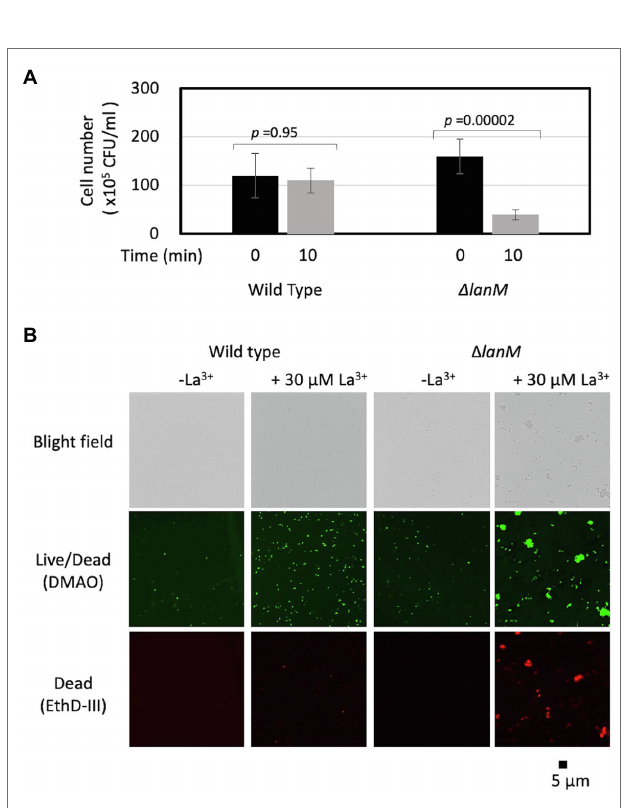
FIGURE 6 | Cell aggregation of Δ lanM upon exposure to La 3+ . (A) Determination of CFUs of the wild type and Δ lanM before and after exposure to 30 μ M La 3+ . Data are presented as the mean value ± standard deviation (SD; n = 3) and analyzed with Student’s t -test. (B) Fluorescent microscopic analysis of the Live/Dead-stained wild type and Δ lanM exposed to 30 μ M La 3+